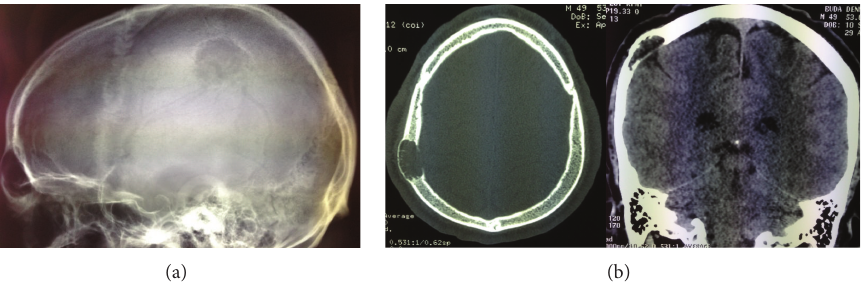
Figure1:(a)SkullX-rayshowingbonyerosion.(b)CTbrainshowinginnertableerosionandthinningoftheoutertablefromtheintraosseous lesion.